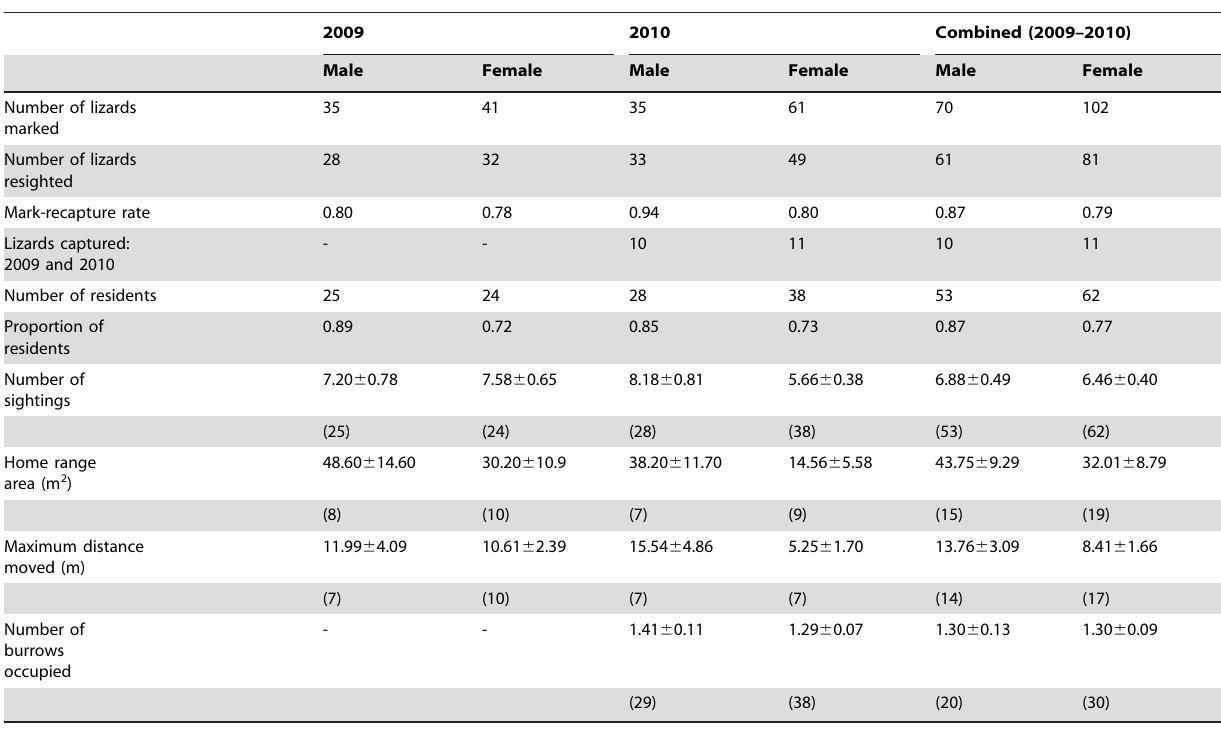
Table 2. The number of unique lizards captured in 2009 and 2010.